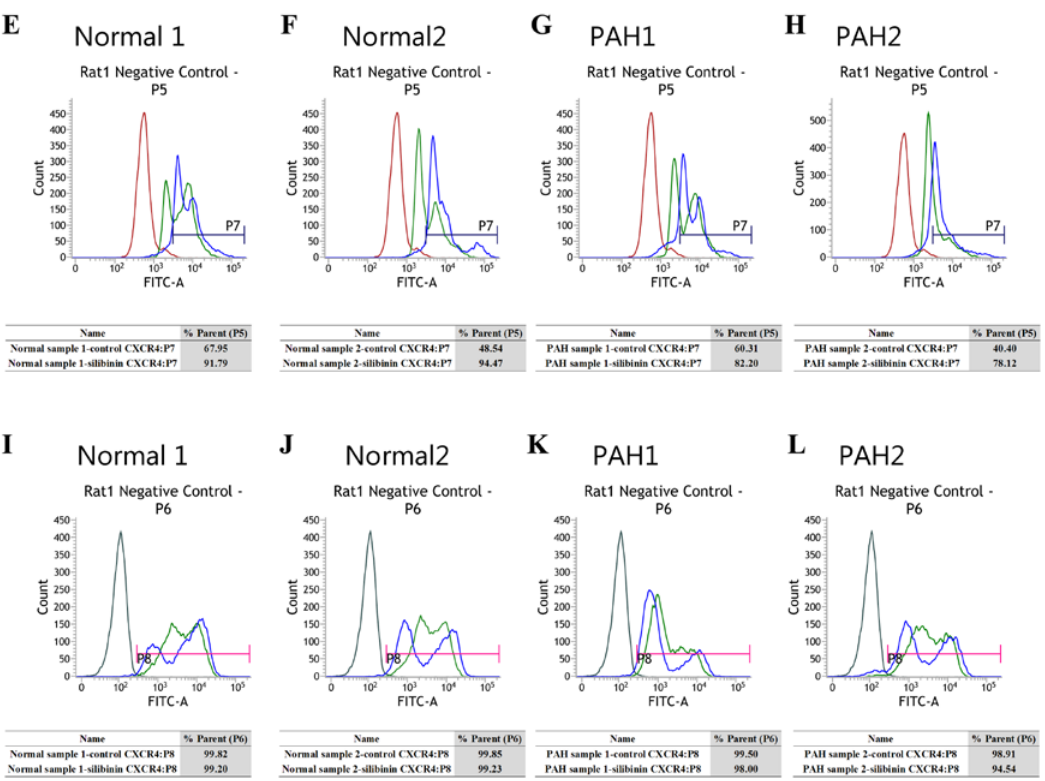
Figure 3. Flow cytometry (FCM) evaluation of CXCR4 in normal and PAH rats. ( A – C ) In the BM of normal rats, silibinin upregulated the percentage of CXCR4-positive cells. Secondary antibody only ( A ), normal 1-control ( B ), and normal 1-silibinin ( C ). ( D ) Negative control of granulocytes (P5 area, red) and negative control of monocyte-macrophages (P6 area, dark green). ( E – H ) In the BM of normal and PAH rats, silibinin increased the percentage of CXCR4-positive cells in the granulocyte fraction. Negative control (red), normal 1-control (light green), and normal 1-silibinin (blue) ( E ). Negative control (red), normal 2-control (light green), and normal 2-silibinin (blue) ( F ). Negative control (red), PAH 1-control (light green), and PAH 1-silibinin (blue) ( G ). Negative control (red), PAH 2-control (light green), and PAH 2-silibinin (blue) ( H ). ( I – L ) In the BM of normal and PAH rats, the percentage of CXCR4-positive cells was not altered in the monocyte-macrophage fraction. Negative control (dark green), normal 1-control (light green), and normal 1-silibinin (blue) ( I ). Negative control (dark green), normal 2-control (light green), and normal 2-silibinin (blue) ( J ). Negative control (dark green), PAH 1-control (light green), and PAH 1-silibinin (blue) ( K ). Negative control (dark green), PAH 2-control (light green), and PAH 2-silibinin (blue) ( L ). Treatment groups consisted of two samples in each